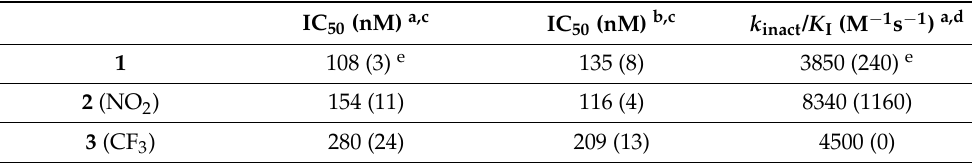
Table 2. Summary of inhibition parameters of compounds 1 – 3 toward commercial and self-produced hTGase